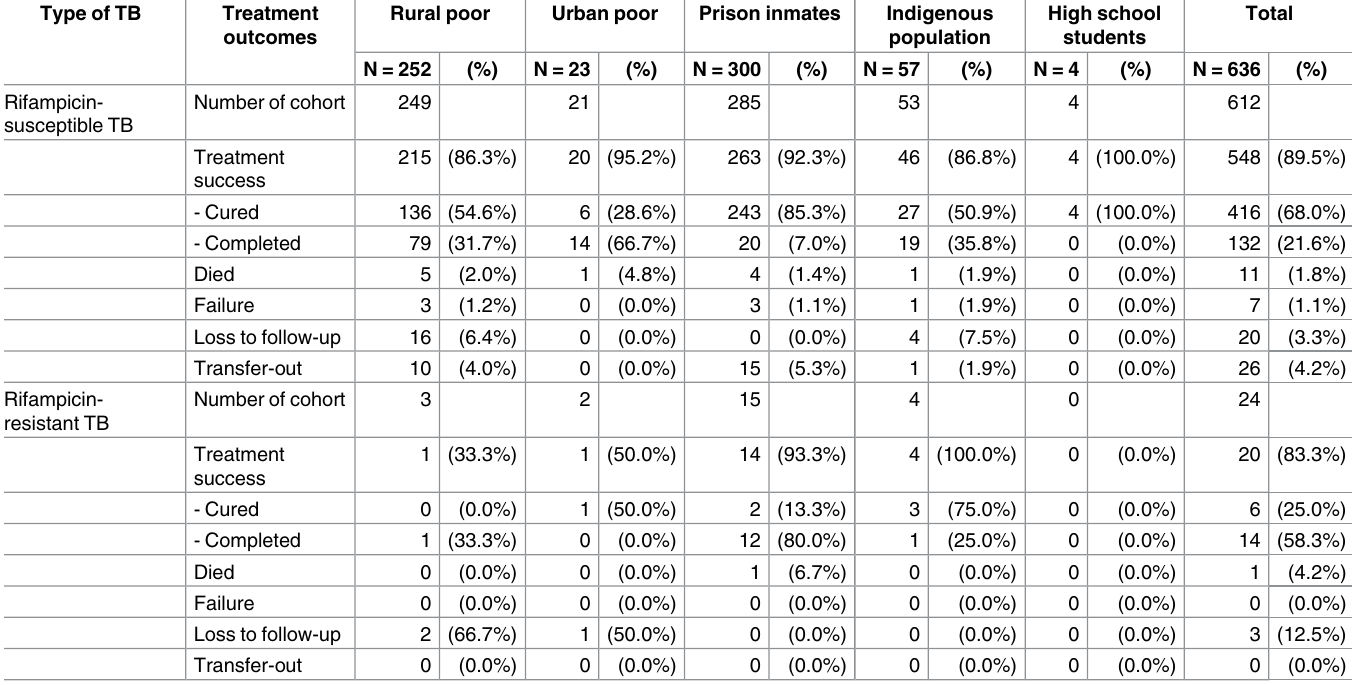
Table 7. Treatment outcomes of TB patients by target